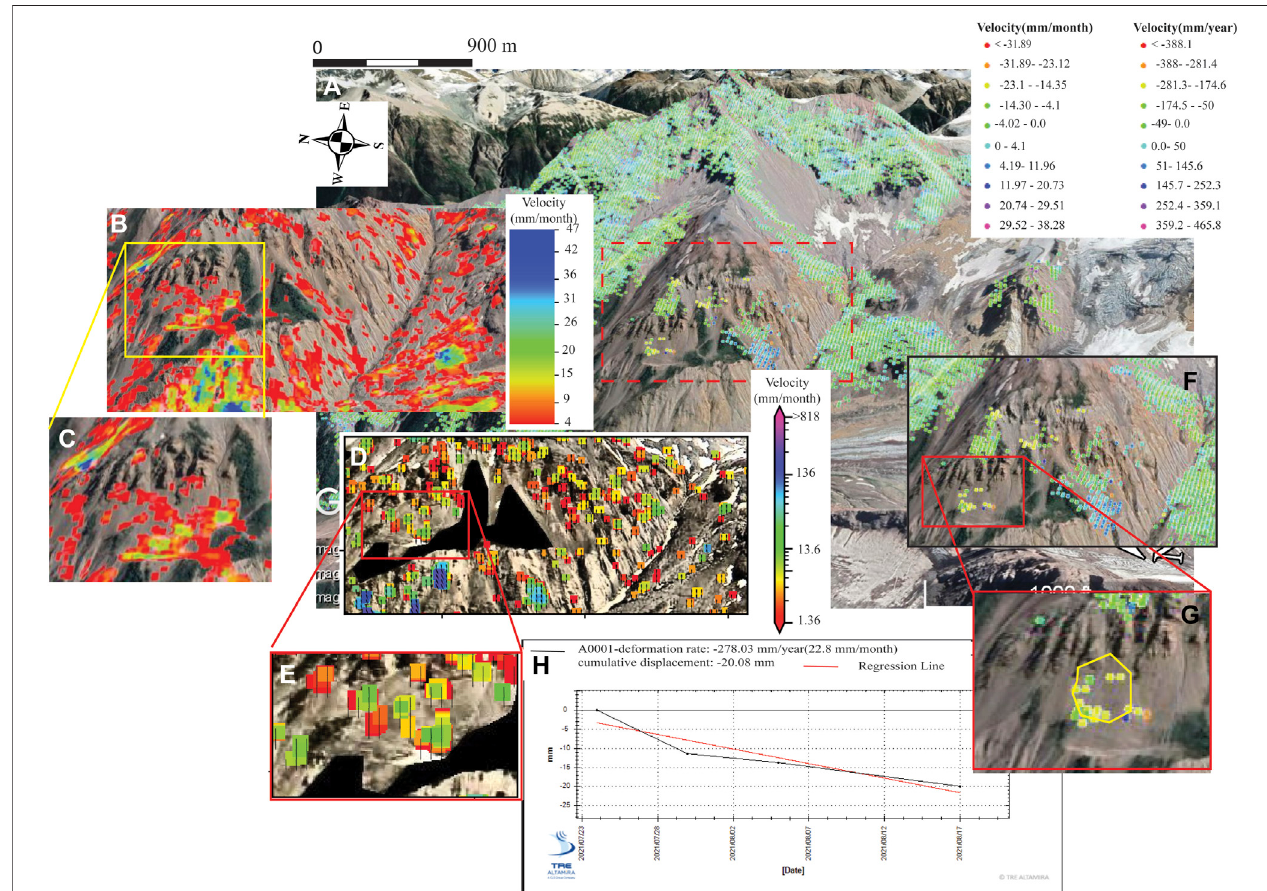
FIGURE 9 | Comparison between Plinth Peak slope displacement from InSAR and average displacement rate calculated from stacked optical velocity triplets for theperiod fromJuly27to18August 2021. (A) Sliced-time window ofSqueeSARresultsbetweenJuly24and17August2021;reddashed rectangleiszoominlocation for panels (B,D,F) . (B,C) are close ins of stacked optical fl ow velocity calculated from orthorecti fi ed optical satellite images. (D,E) are close ins of stacked optical fl ow velocity calculated from ground-based optical images. (F,G) are close ins of processed time-series radar images using SqueeSAR. (H) InSAR displacement timeseries for the yellow polygon in (G) See Figure 1 to locate the extent of Figure 9 . The colour bar for panels (D,E) represented as logarithmic scale.